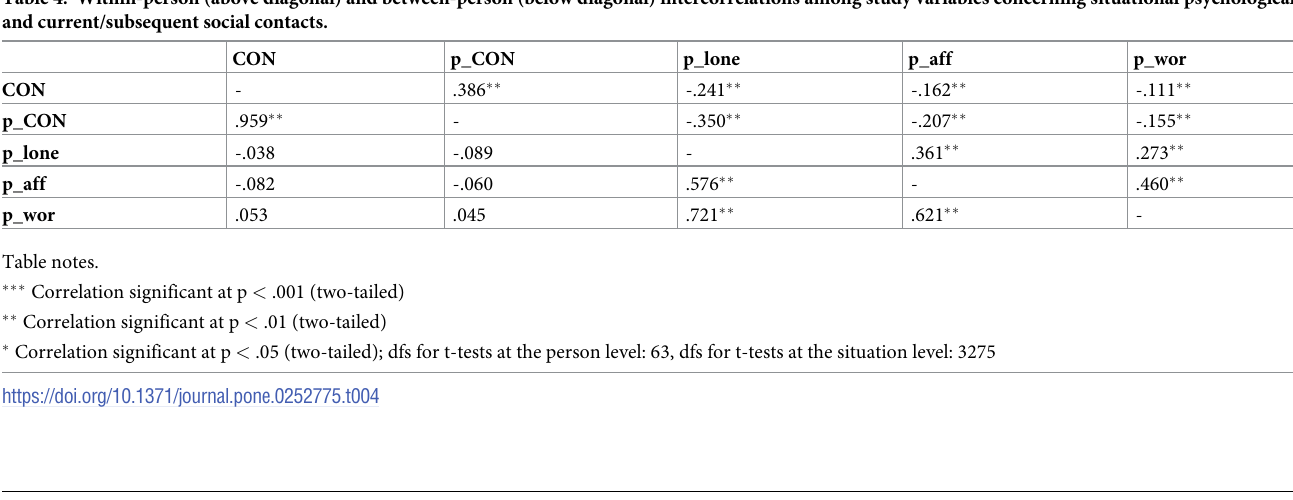
Table notes. M(SD)–Mean value and standard deviation in parentheses; T–ESM data derived from assessments conducted at a respective timepoint ‘i’, ‘i-1’ or from some other source of information; ts–data derived from timestamps automatically set by the ESP software; dp–data derived during the process of data preparation.